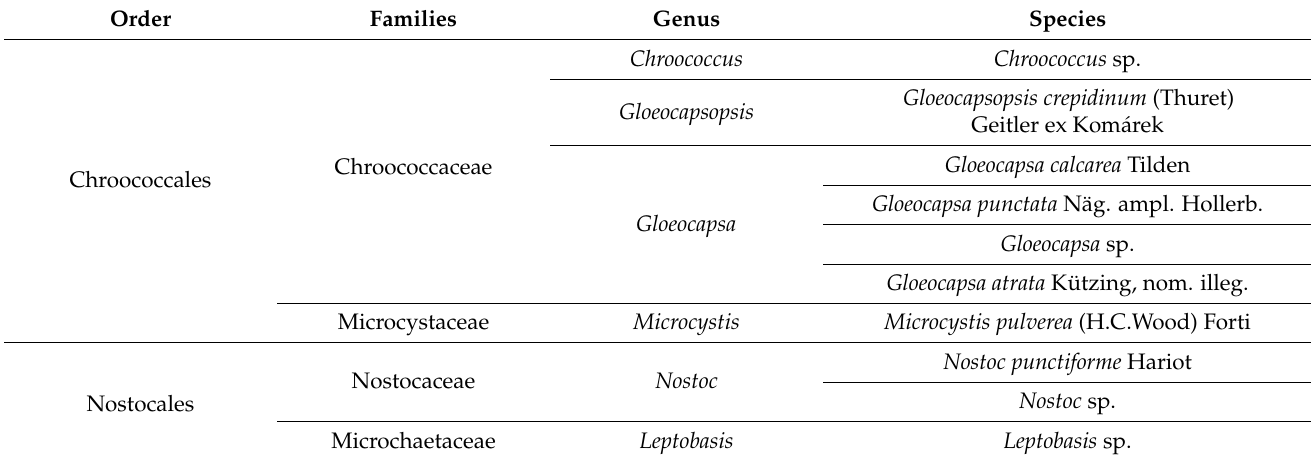
Table 4. Taxonomic list of identified